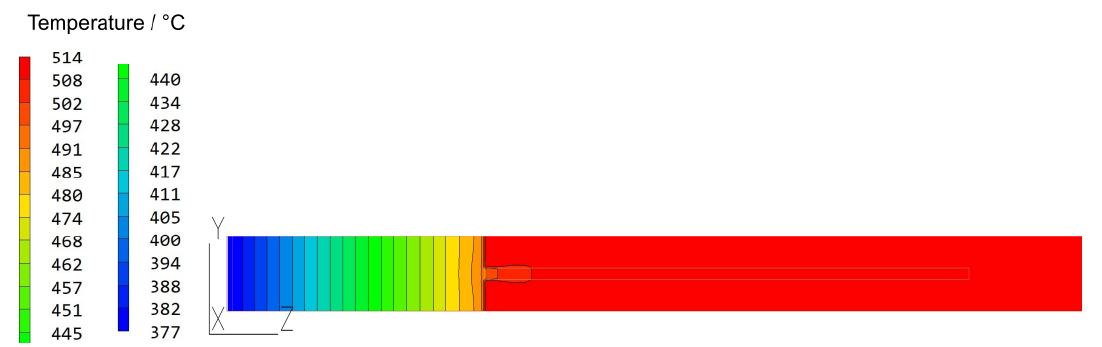
Figure 4. Simulation results showing the quasi-steady temperature distribution, which was used as initial values for the calculation to estimate thermocouple response, shown in Figure 5. The direction of gravity is from left to right. See Figure 2 for explanatory details of the simulation domain.